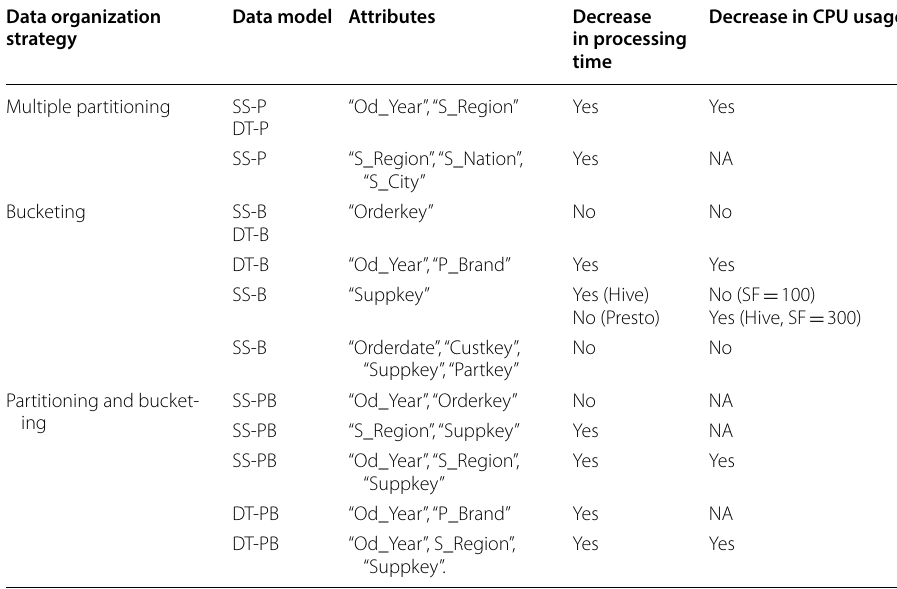
Table 14 Data organization strategies and their impact on processing time and CPU usage (NA: Not